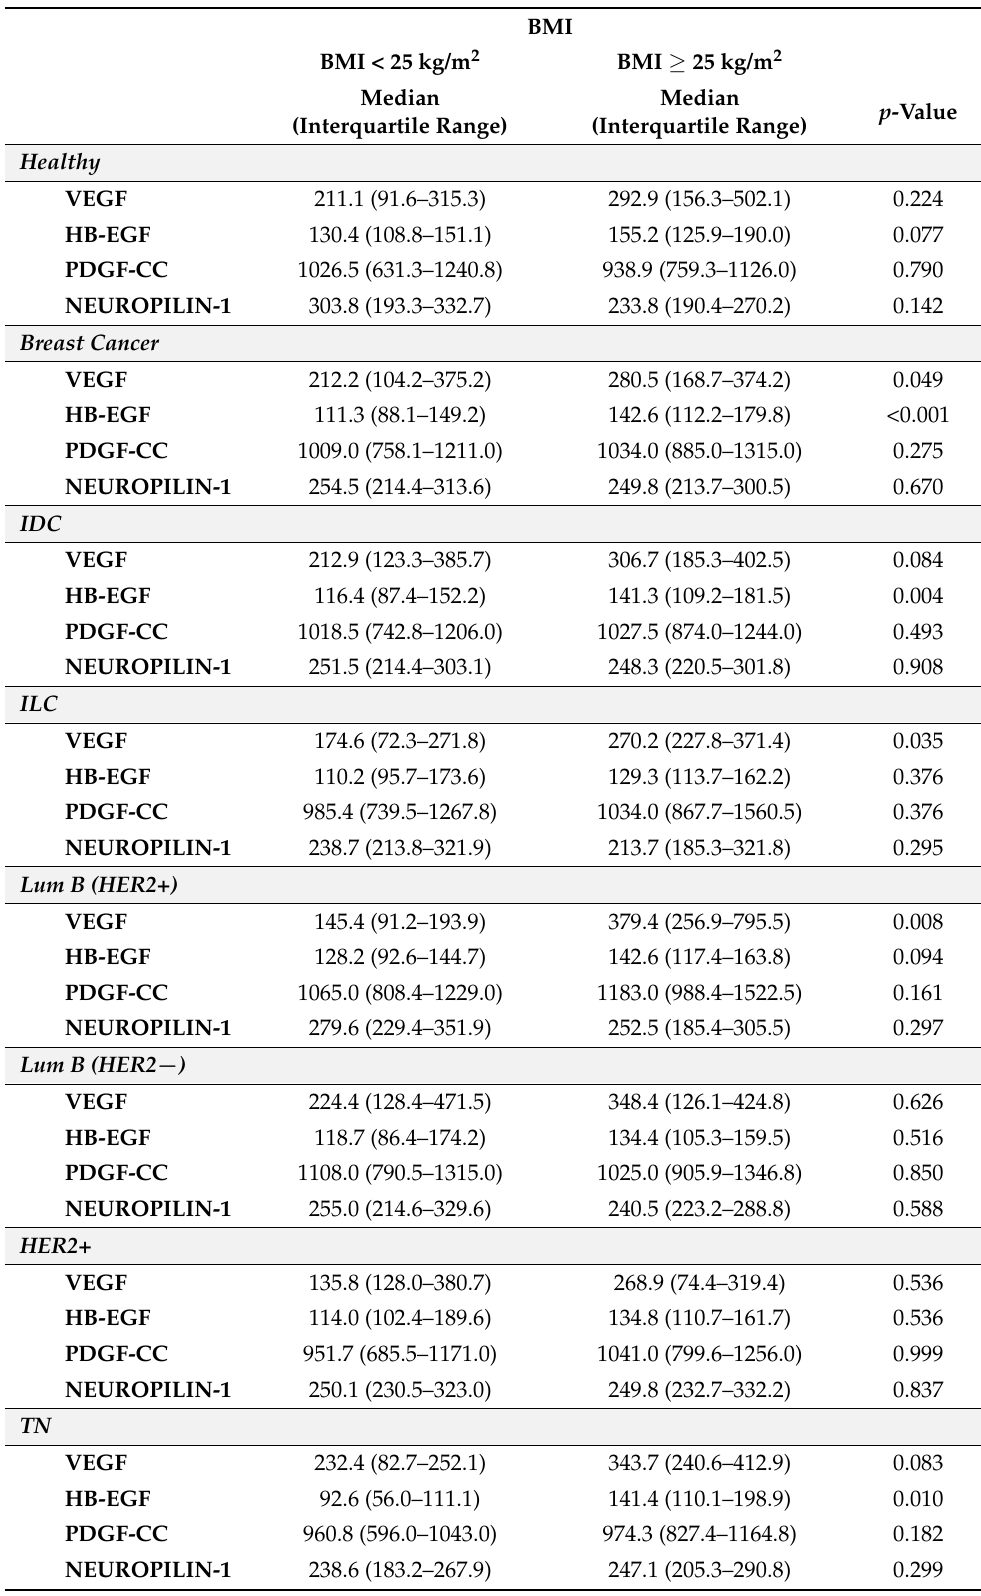
Table 4. Differences in molecule levels considering BMI values and histological types/molecular subtypes of breast